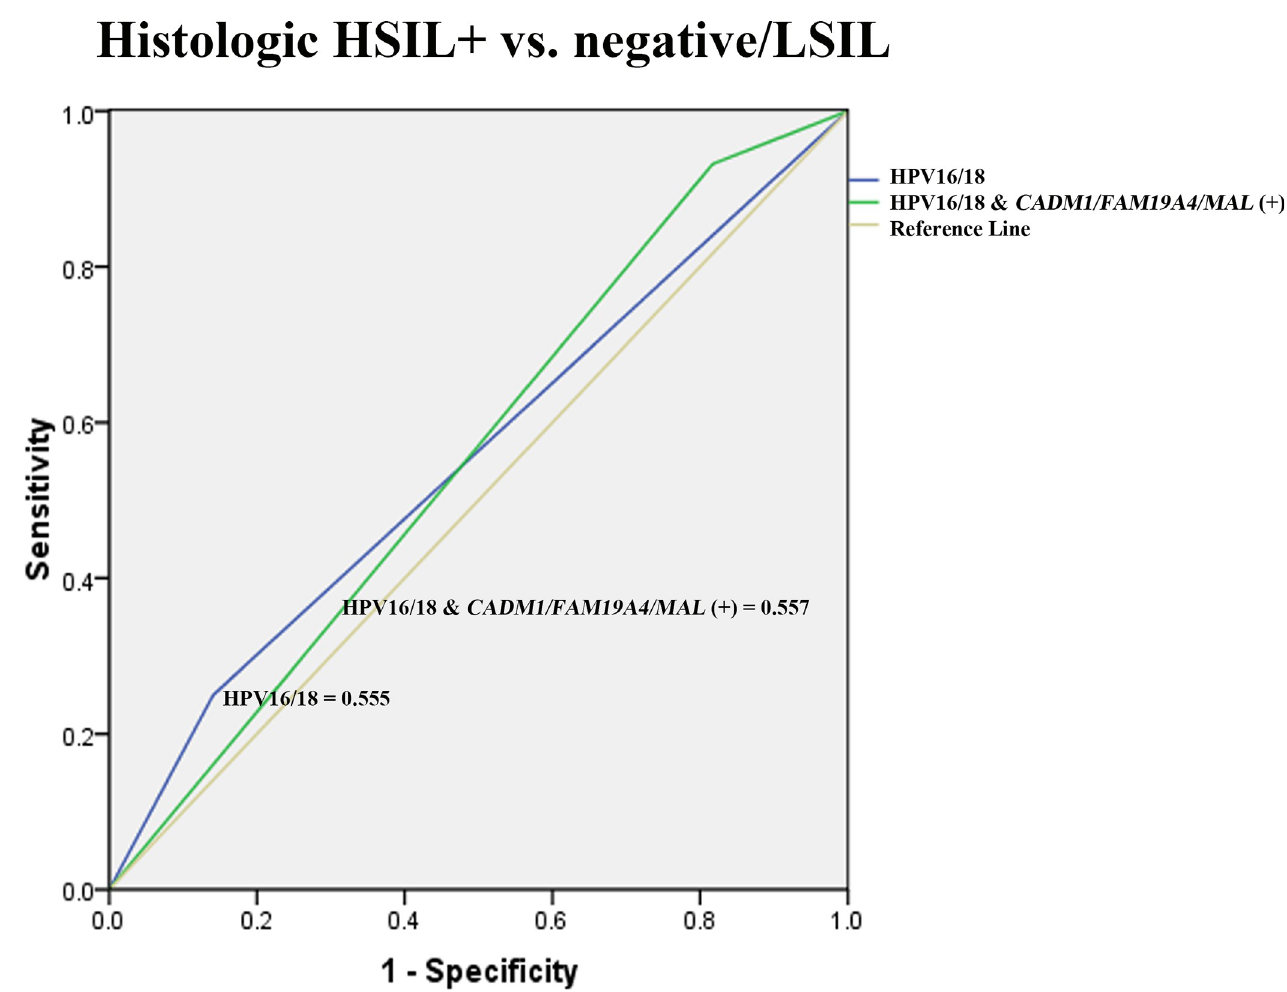
Fig 6. The ROC curve analysis of HPV16/18 and the combination of DNA methylation markers and HPV16/18 in differentiating histologic HSIL+ from negative/LSIL.